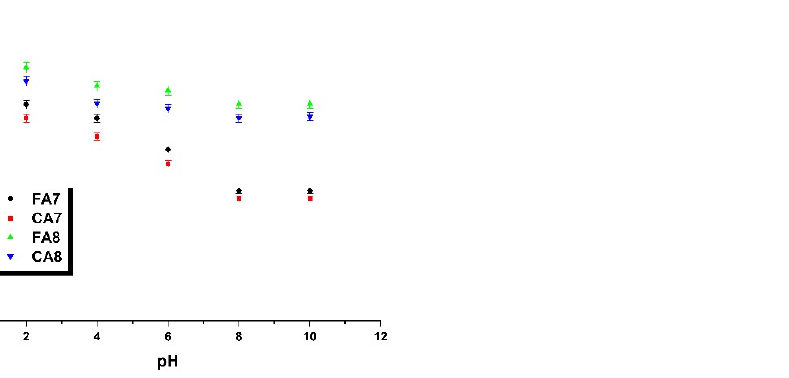
Figure 8. The pH influence on the adsorption of methyl red sodium salt (biocarbon mass: 25 mg, initial dye solution concentration: 40 mg/L, methyl red sodium salt solution volume: 50 mL, temperature: 23 ± 1 ◦ C).